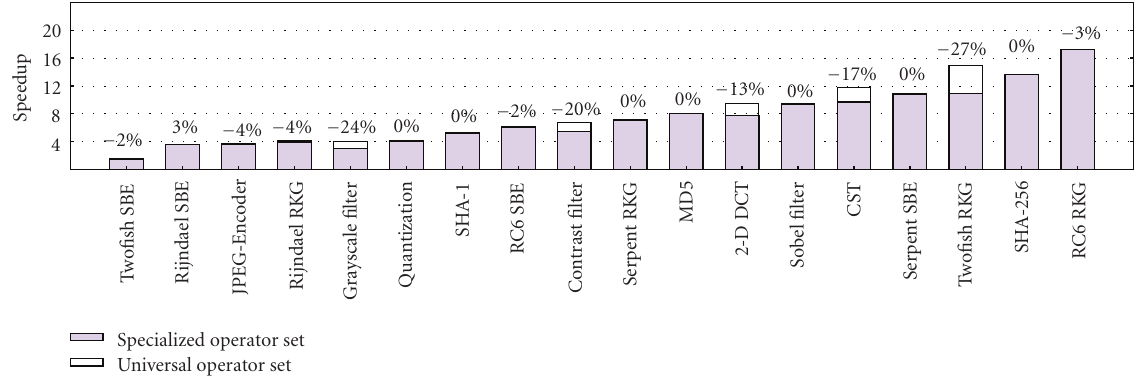
Figure 12: Speedup of benchmark applications on a specialized 8 operator array with 1 multiplication and 1 division operator.